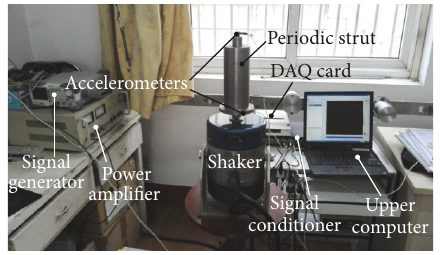
Figure 6: Experimental setup of shaker